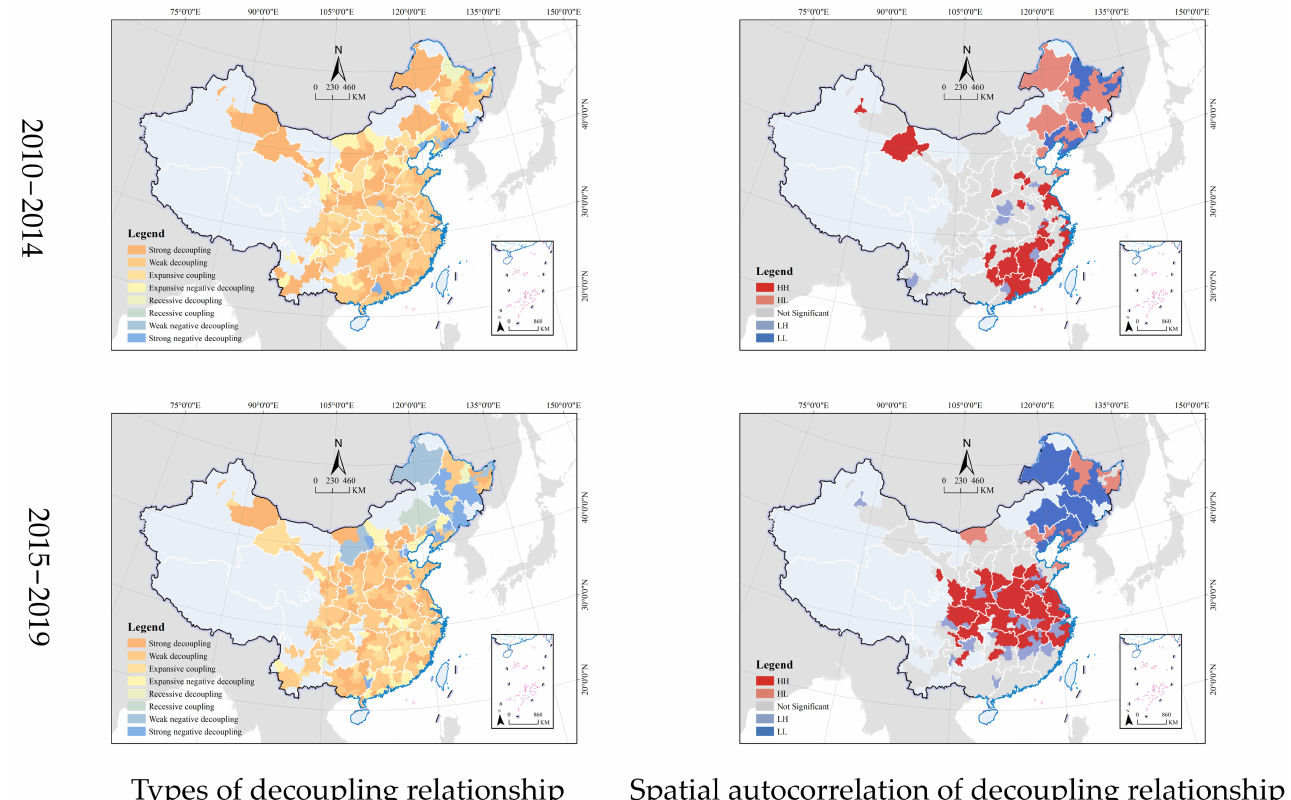
Figure 7. Decoupling type and spatial autocorrelation of industrial land and gross domestic